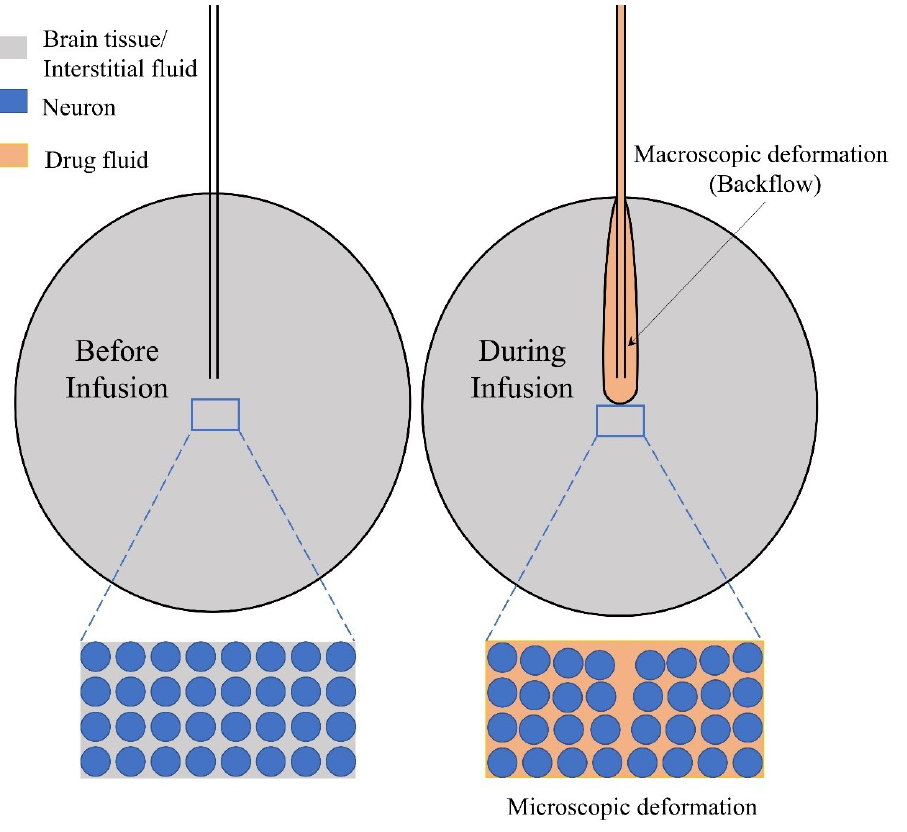
Figure 3. Schematic representation of macro- and microscale deformation of brain parenchyma during